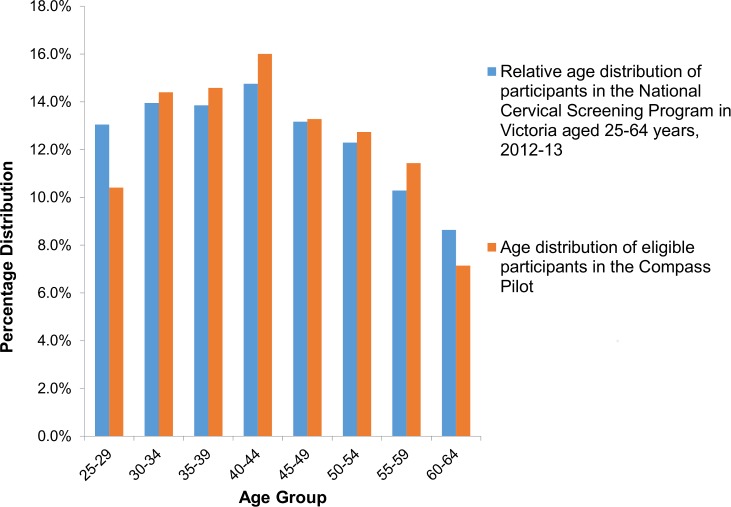
Participant age distribution, compared to those routinely attending cervical screening in Victoria.Data on women attending in Victoria for cervical screening in Australia 2012–2013 are from the Australian Institute of Health and Welfare [21].